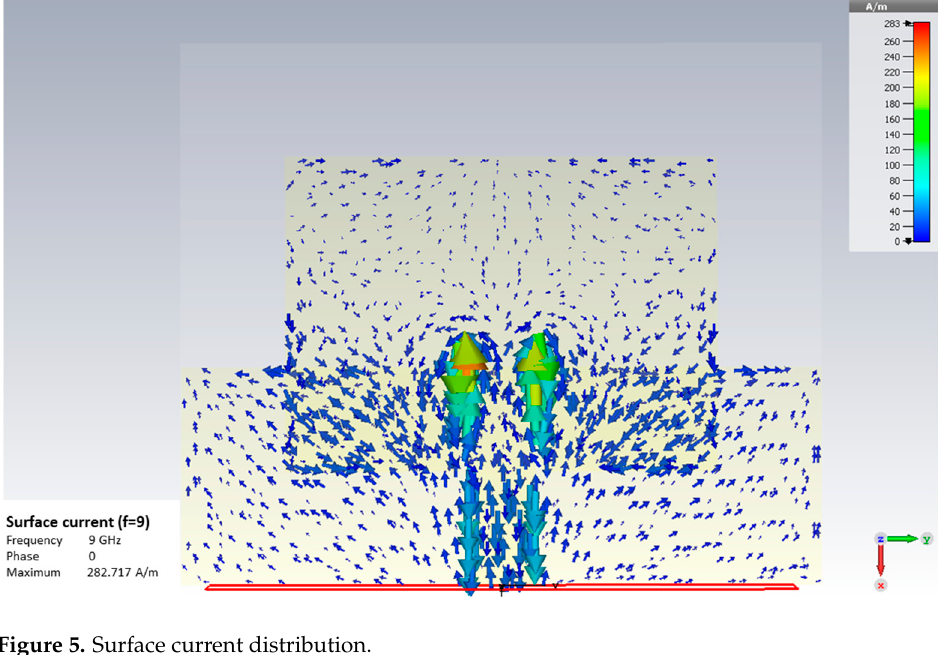
Figure 5. Surface current distribution.